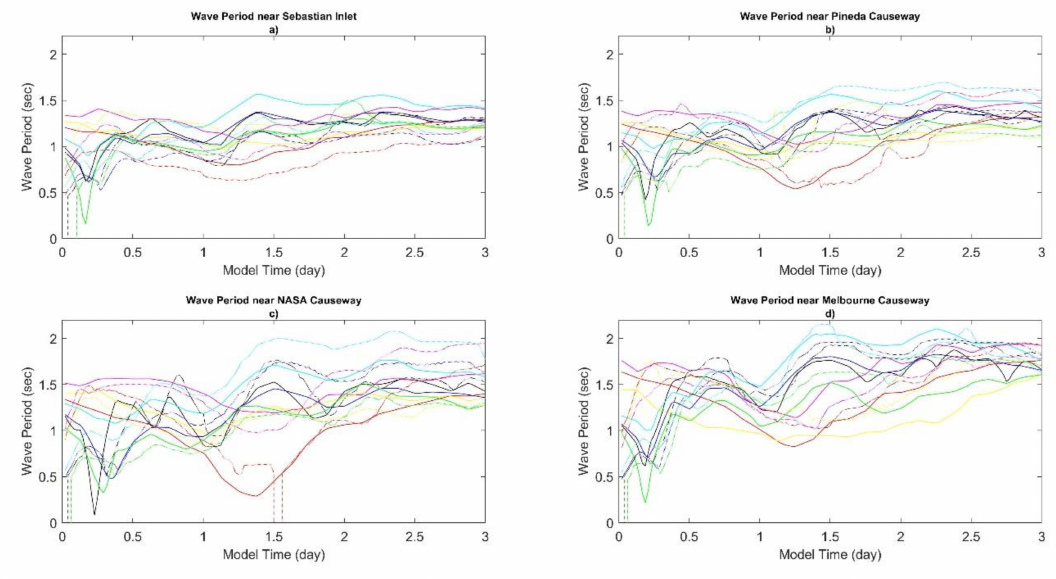
Figure A4. Time series plots of individual ADCparam and ADCIRC + SWAN ensemble members for wave period (seconds) near ( a ) Sebastian Inlet, ( b ) Pineda Causeway, ( c ) NASA Causeway, and ( d ) Melbourne Causeway. The legend is shown in Figure A1. Each of these locations is selected based on location in the domain and associated fetches (station locations are specified in Figure